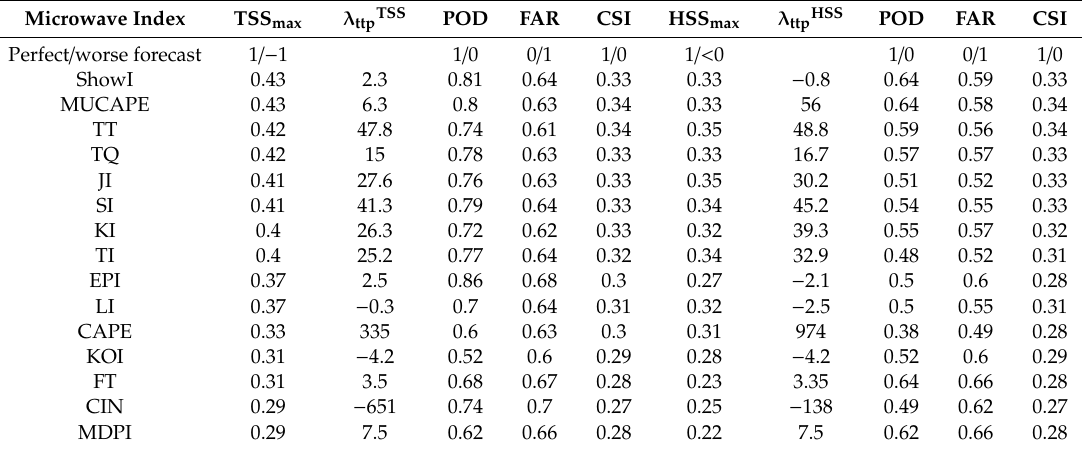
Table 2. The prediction skills of microwave indices. The best indices are on the